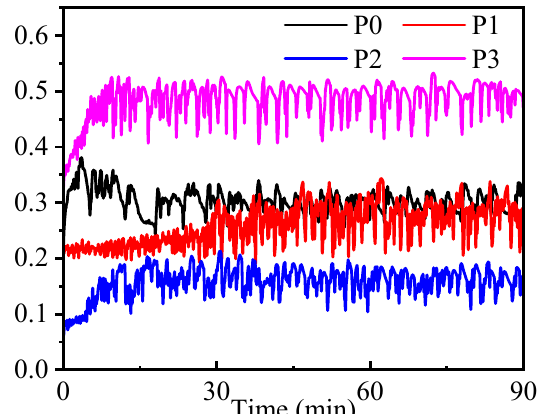
Figure 11. The effect of ultrasonic vibration power on friction coefficient of laser cladding ceramic coatings.